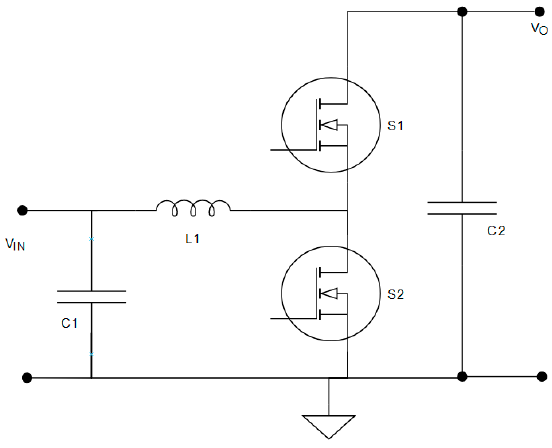
Figure 19. Basic circuit schematic of a boost